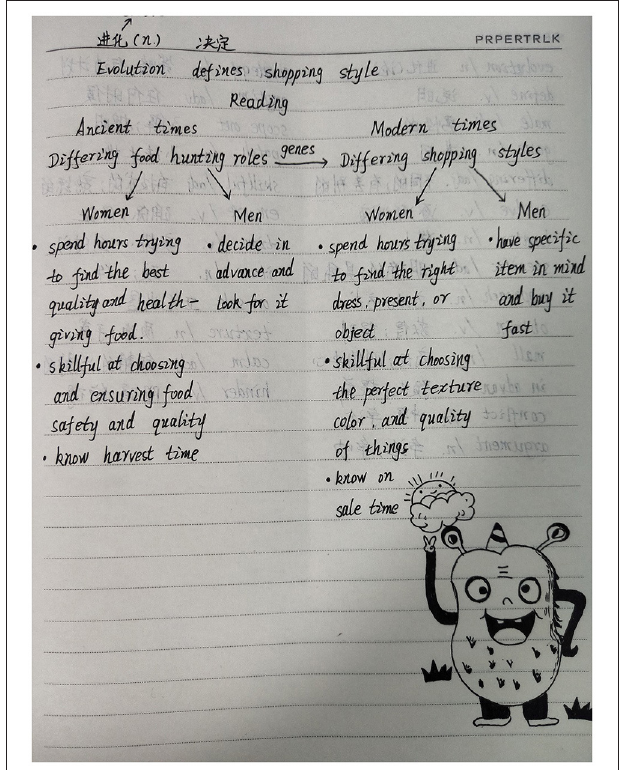
FIGURE 3 | Participant A’s class